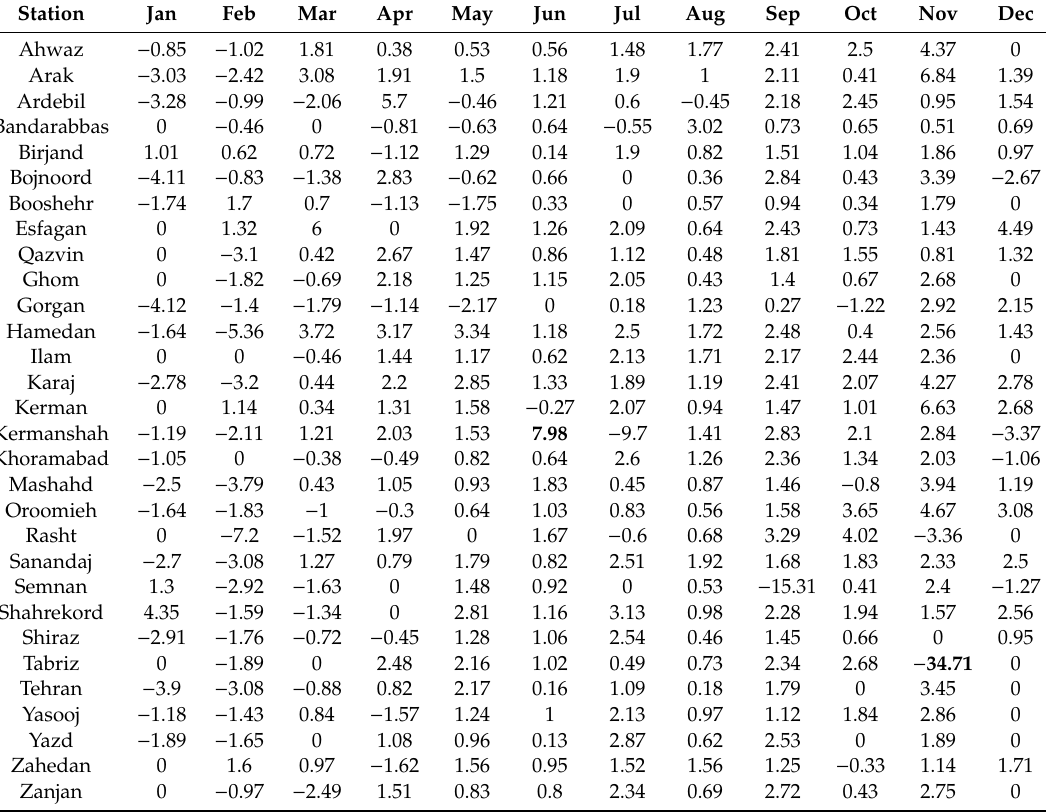
Table 1. Change percentages of the ET 0 predicted for the period from 2011 to 2045 under the A1B scenario.